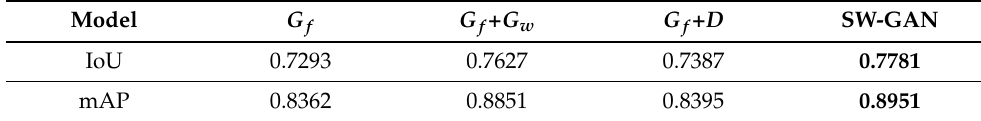
Table 6. Ablation experiments on Dataset 1 (bold: